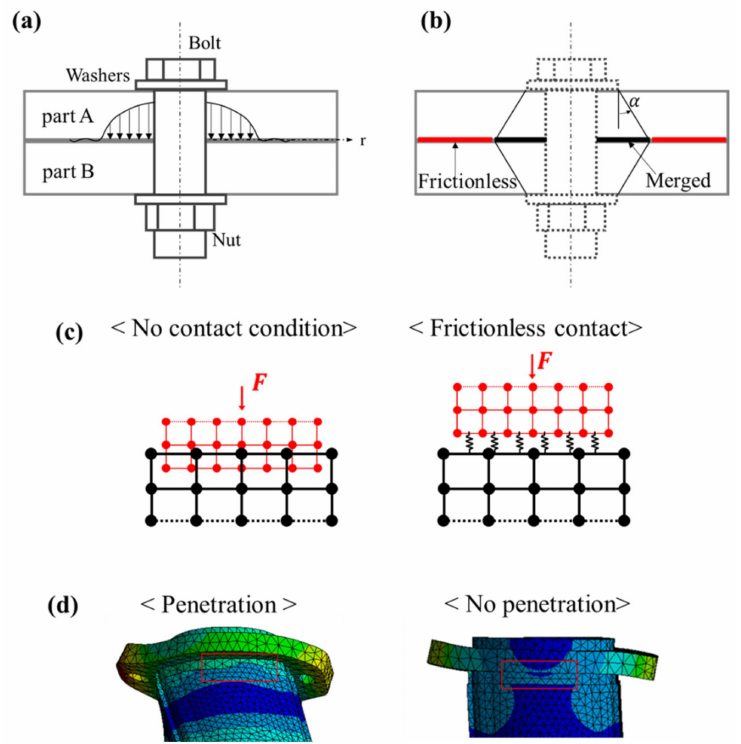
Figure 10. ( a ) Qualitative illustrations of normal stress distribution when the clamping force is applied [40], ( b ) schematic of modeling bolted connection, ( c ) graphical representation for the model in FEM when contact condition is not applied ( left ) and frictionless contact is applied ( right ) [43], and ( d ) the mode shape of the pump when contact condition to the area outside of the merged area for the bolted connections is not applied ( left ) and frictionless contact is applied ( right